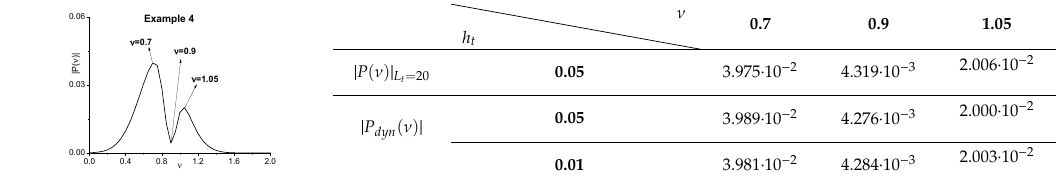
Table A1. Integral spectral amplitude for the artificial signal (Example 4). Table A1 . Integral spectral amplitude for the artificial signal (Example